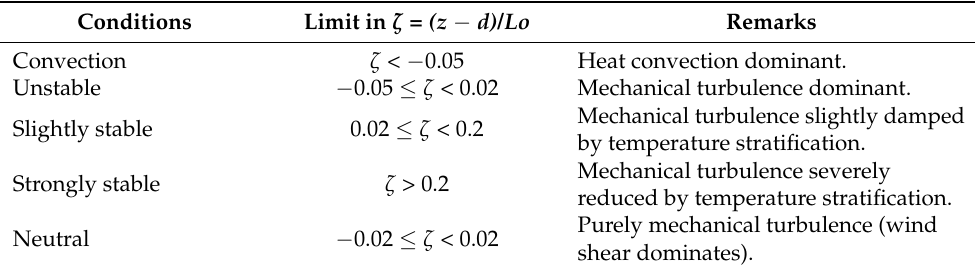
Table 1. Stability conditions based on Monin–Obukhov length [30,31].